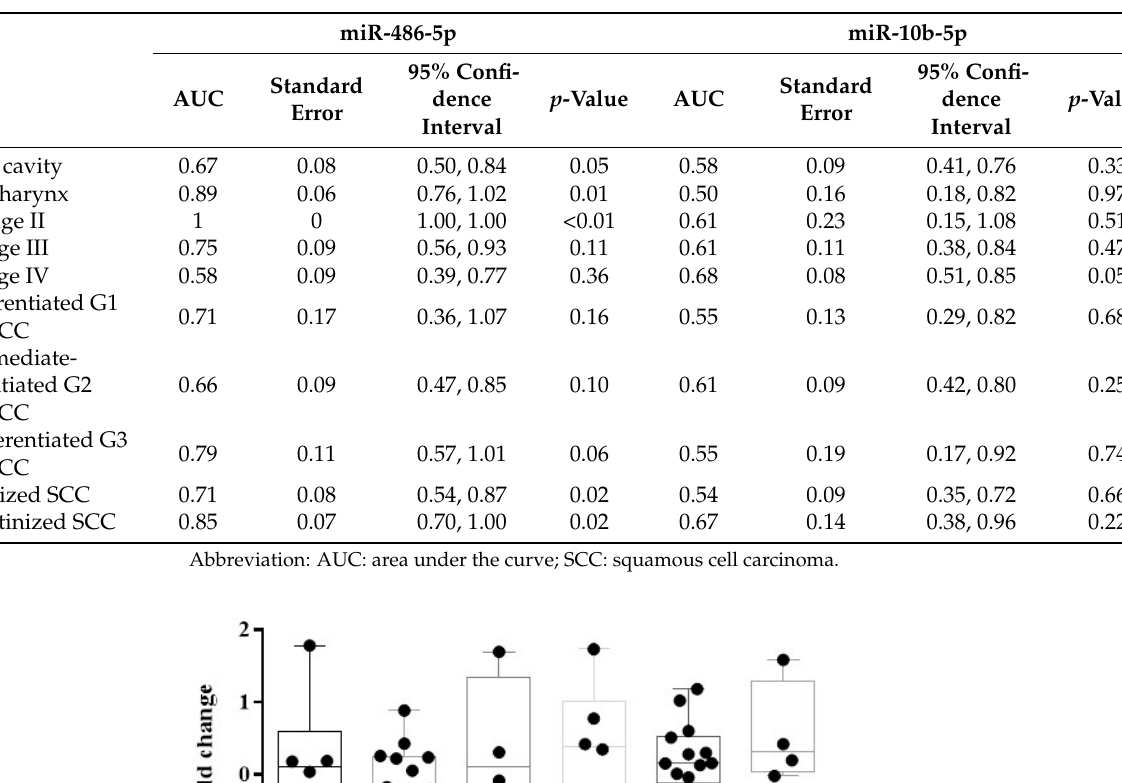
Table 3. Area under the curve of oral and oropharyngeal cancer detection using miR-486-5p and